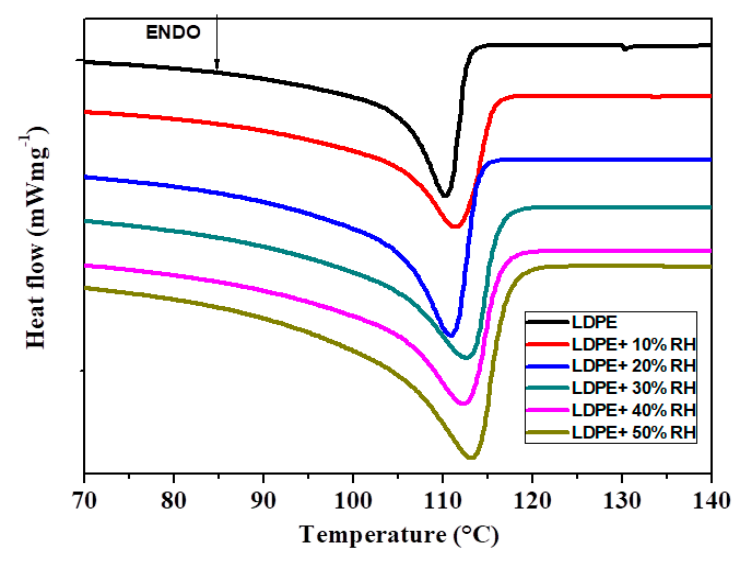
Figure 10. Melting behaviour of the neat LDPE and LDPE/RH biocomposites recorded during heating by 10 °C/min.